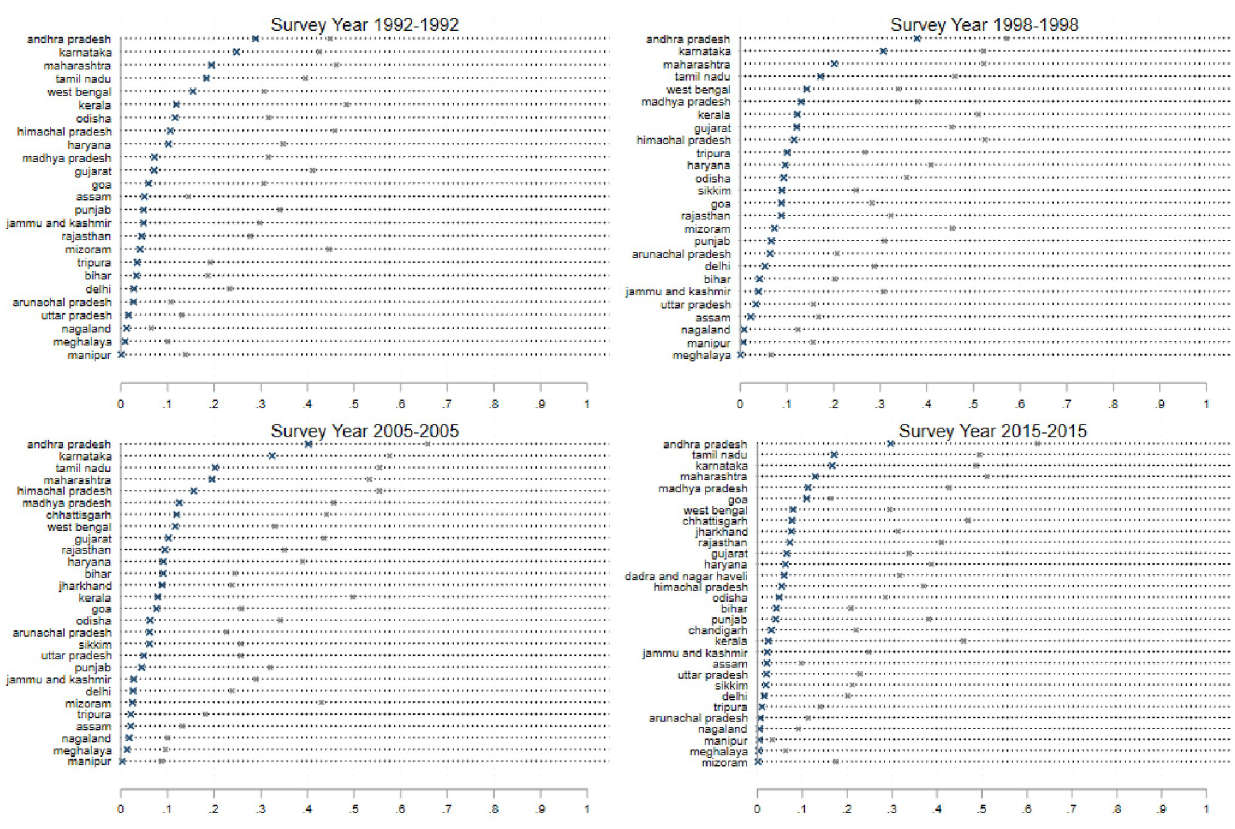
Fig 4. State level breakdown; sterilization; percentage of women married, ages 18–24 (marked as × ) and age Age25+ (marked as � ).